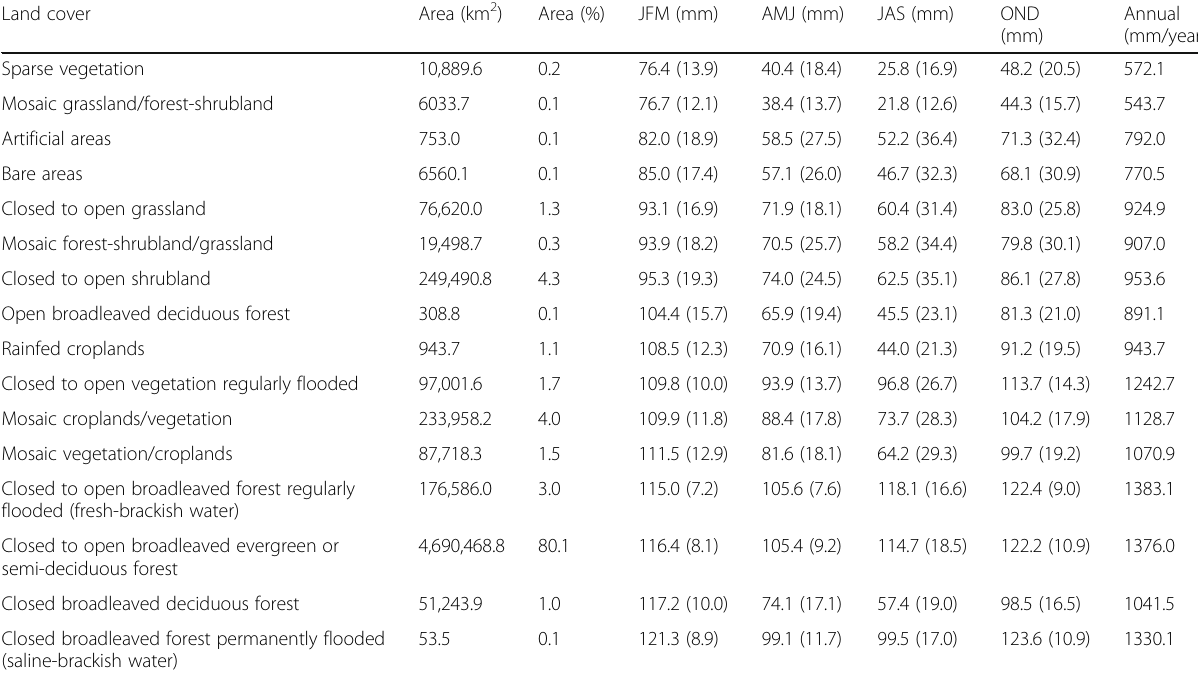
Table 8 Mean seasonal ET (and standard deviation) from ET-Amazon parsed by land cover and land use class (http://